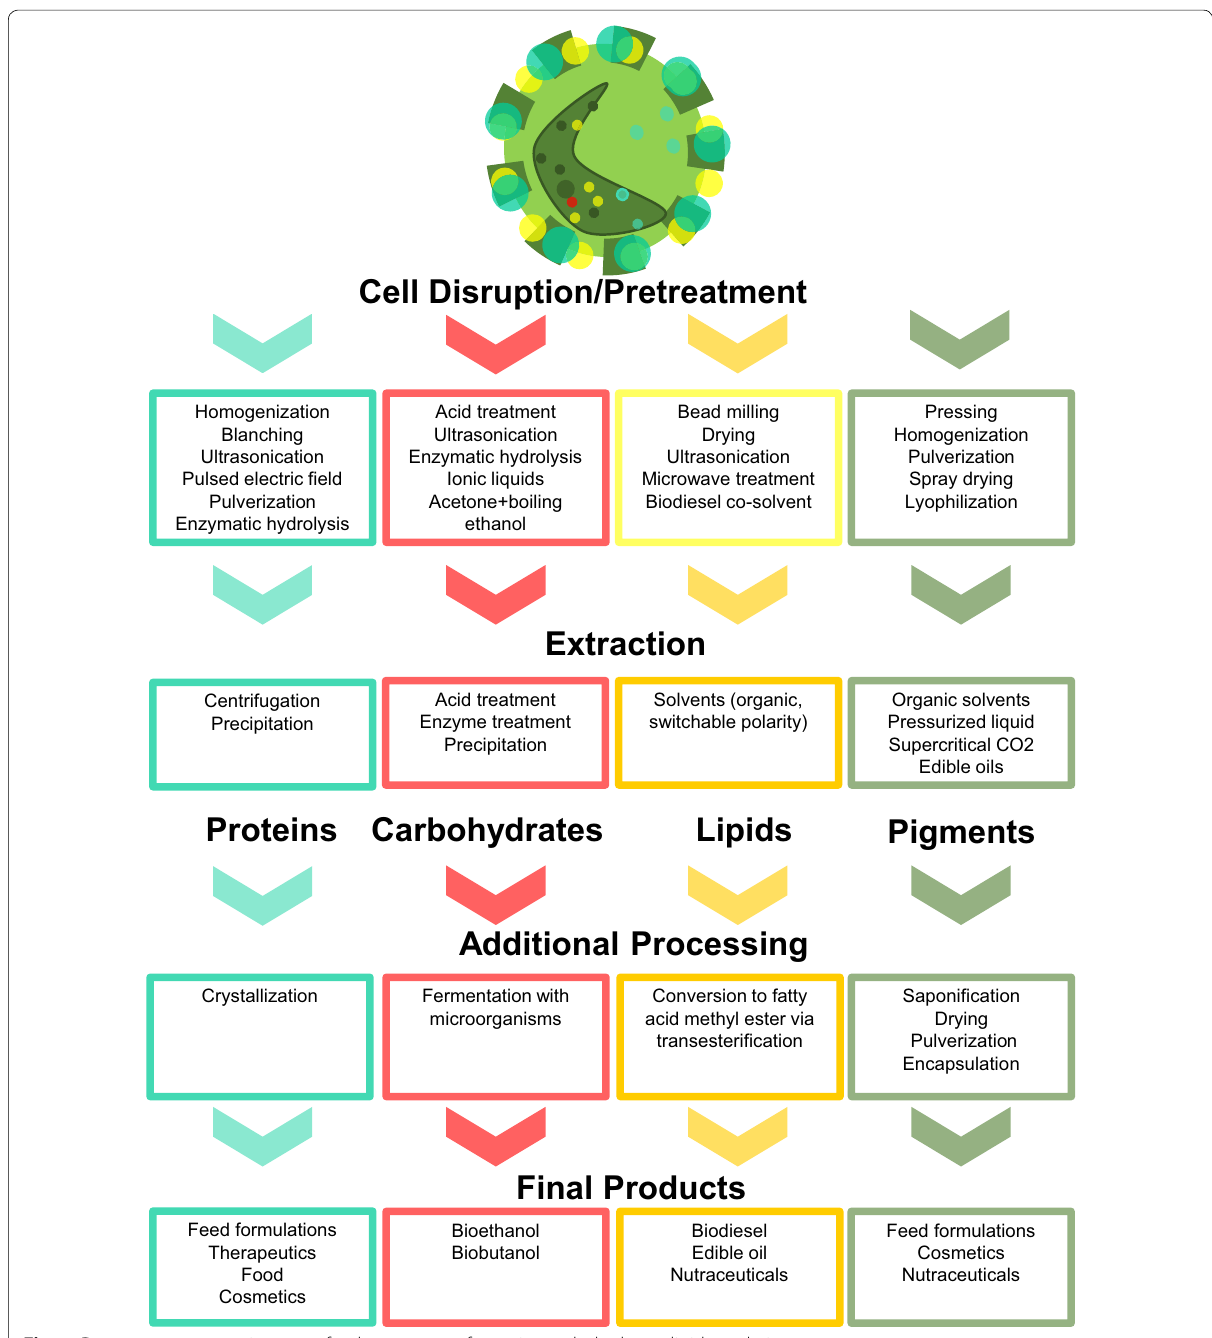
Fig. 1 Downstream processing steps for the recovery of proteins, carbohydrates, lipids, and